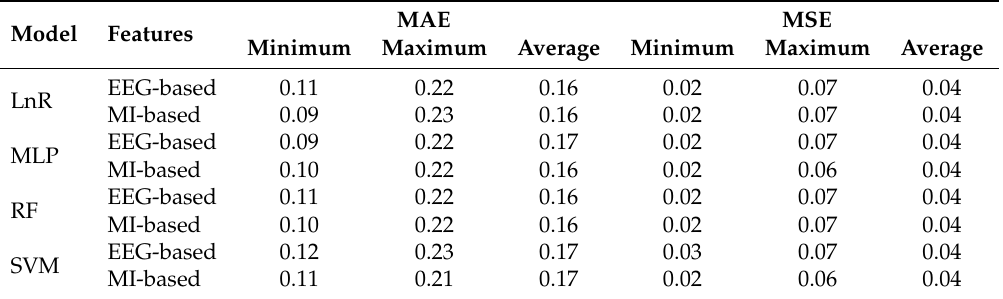
Table 4. The 10-fold CV summary in terms of Mean Absolute Error and Mean Squared Error for predicting MWL score using EEG and Mutual Information (MI)-based features.